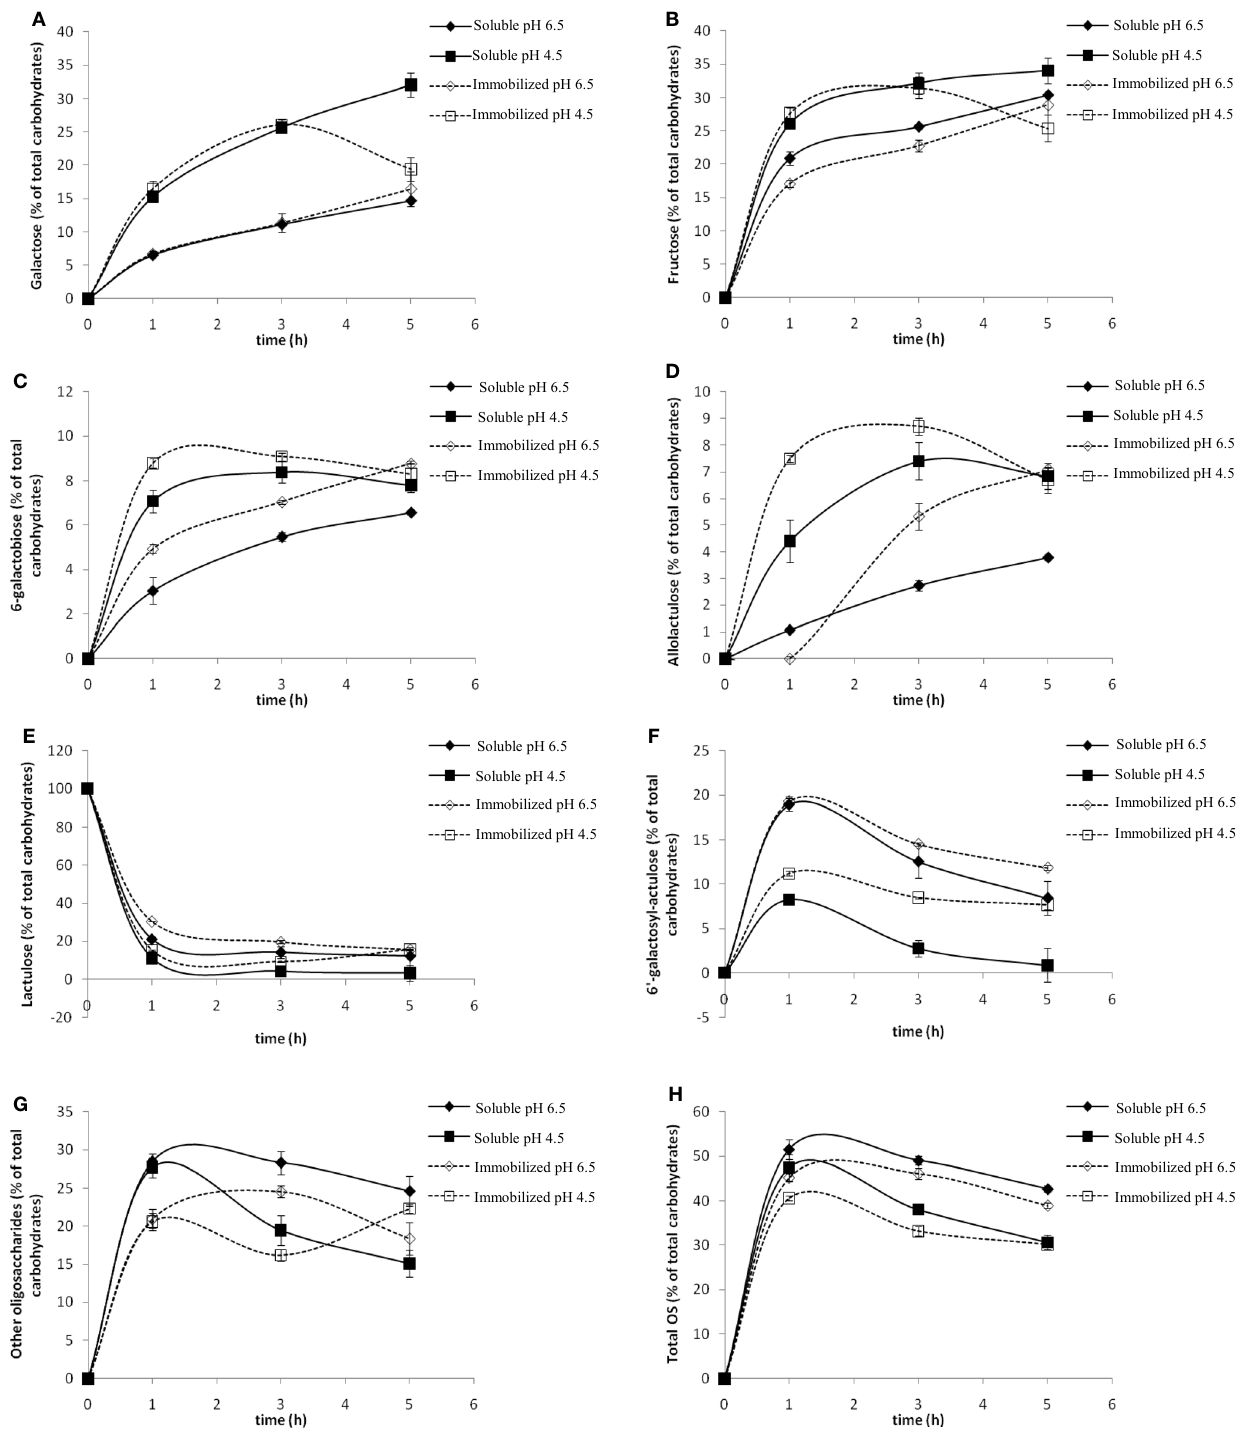
FigUre 3 | effect of ph on the content of (a) galactose, (B) fructose, (c) 6-galactobiose, (D) allolactulose, (e) lactulose, (F) 6 ′ -galactosyl-lactulose, (g) other oligosaccharides (hrTOs, with DP ≥ 3), and (h) total oligosaccharides during the enzymatic hydrolysis of lactulose (450 g/l) with soluble (continuous lines, 8 U/ml) and immobilized (dotted line, 8 U/ml) Aspergillus oryzae β -galactosidase at 50 °c: ( ▴ , ∆ ) ph 6.5; ( ▪ , ◻ ) ph 4.5